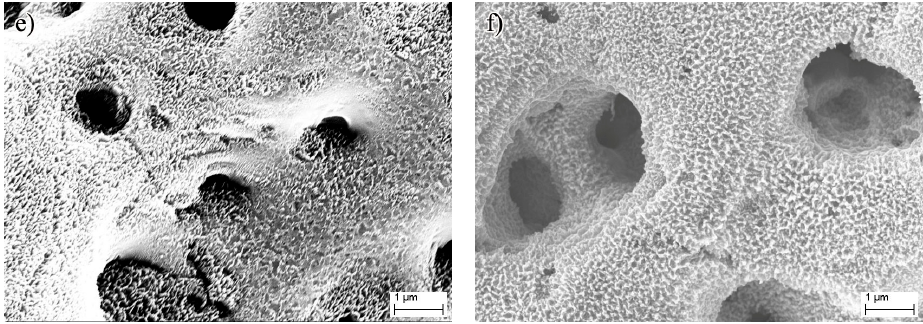
Figure 2. Surface morphologies of the micro-arc oxidation and nitrogen ion implantation (MAO-NII) modified specimens with different N ion implantation doses: ( a ) Ti-MAO-N0.1; ( b ) Ti-MAO-N0.5; ( c ) Ti-MAO-N1.0; ( d ) Ti-MAO-N5.0; ( e ) Ti-MAO-N10; and ( f ) Ti-MAO-N20.